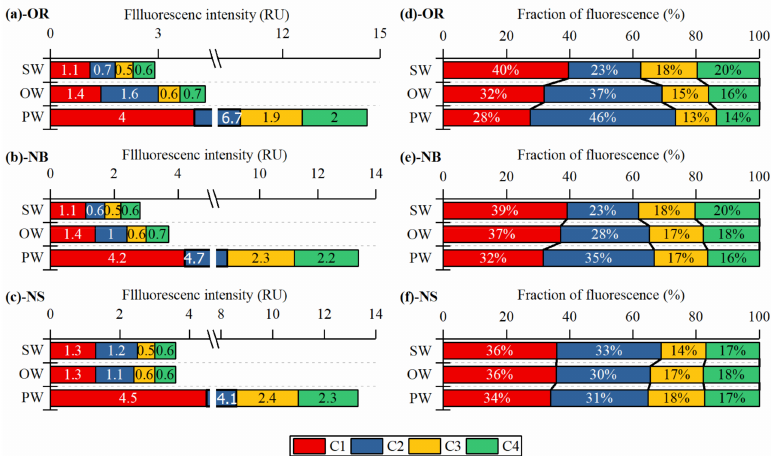
Figure 4. Bar charts of the F max of four components in SW, OW and PW from ( a ) OR, ( b ) NB, ( c )